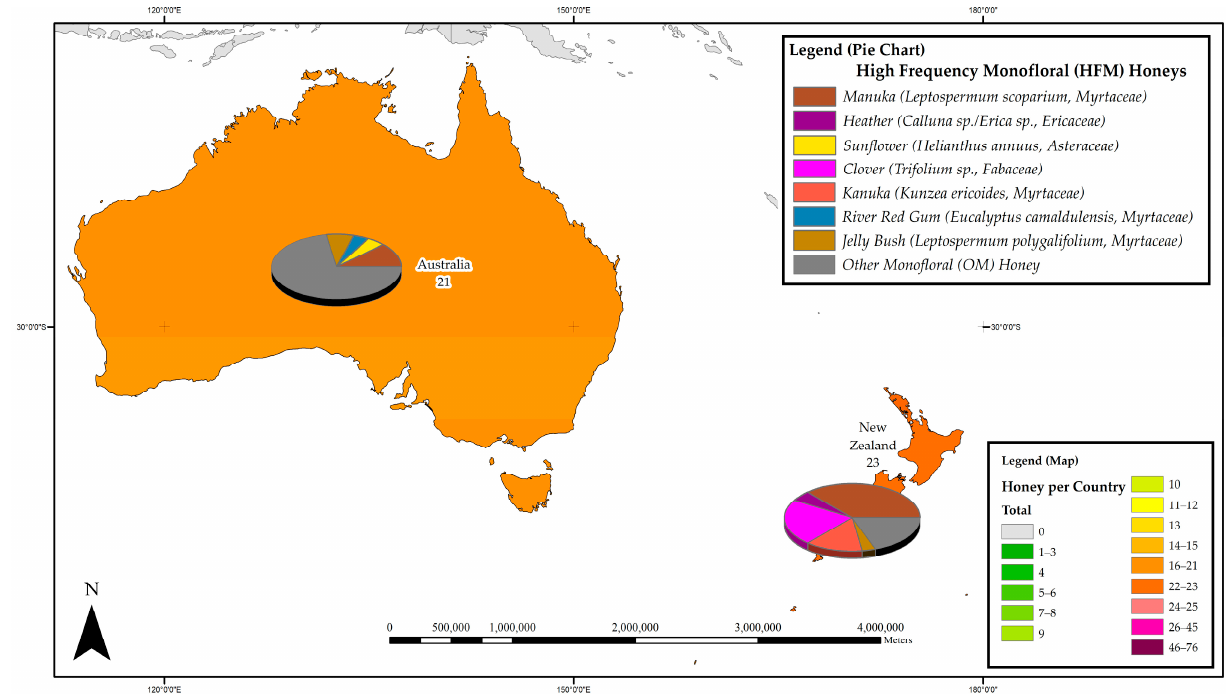
Figure 2. Most frequently studied honeys with respect to their phenolic profile in Australia and New Zealand.